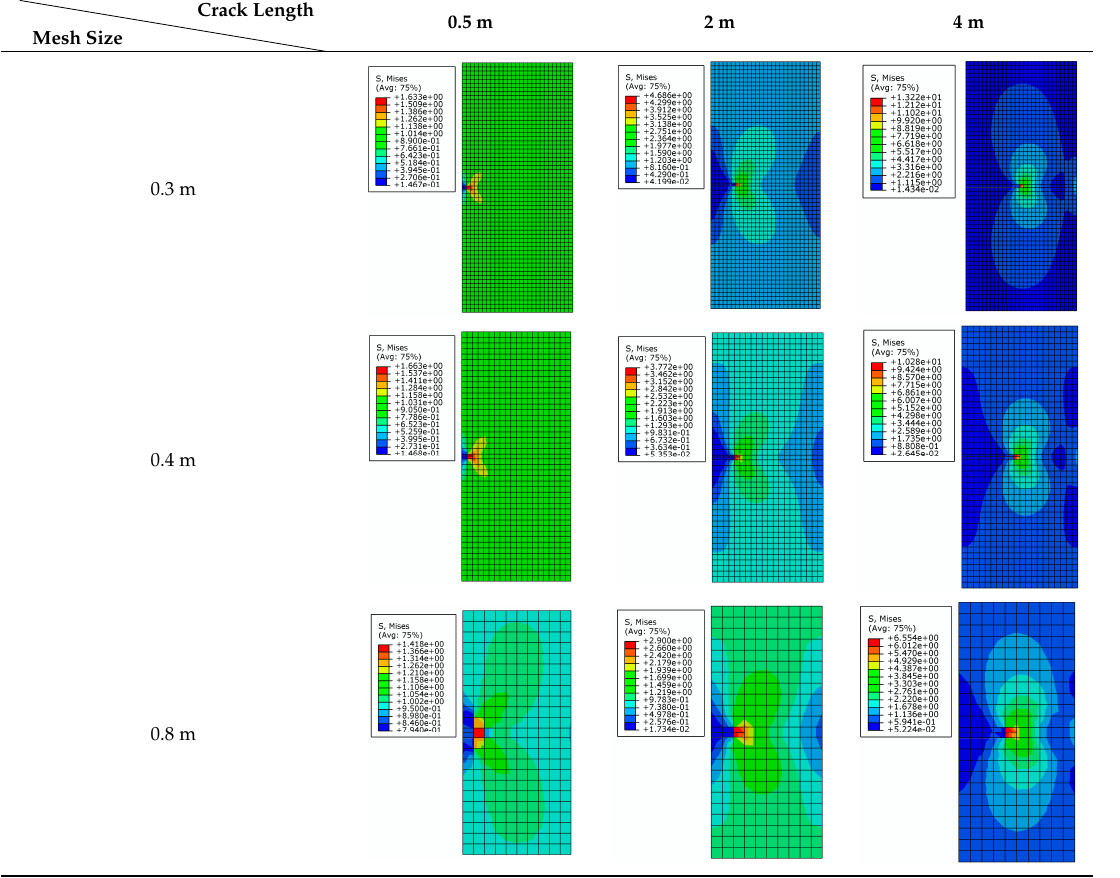
Figure 5. Stress intensity factors for different initial crack lengths and mesh densities. Table 3. The von Mises stress distribution of the rectangular plate for different crack lengths and mesh sizes.